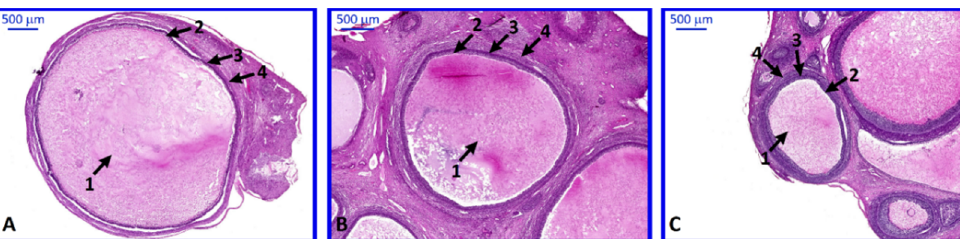
Figure 10. Individual isolated follicles stained with routine H and E method. Follicles varied in size; we can observe large ( > 5 mm), medium (3–5 mm) and small follicles ( < 3 mm). Medium and small follicles were collected in groups containing more than one follicle. ( A )—large follicle, ( B )—medium follicle, ( C )—small follicle. Arrows: 1—antrum, 2—granulose cells, 3—theca interna, 4—theca externa.